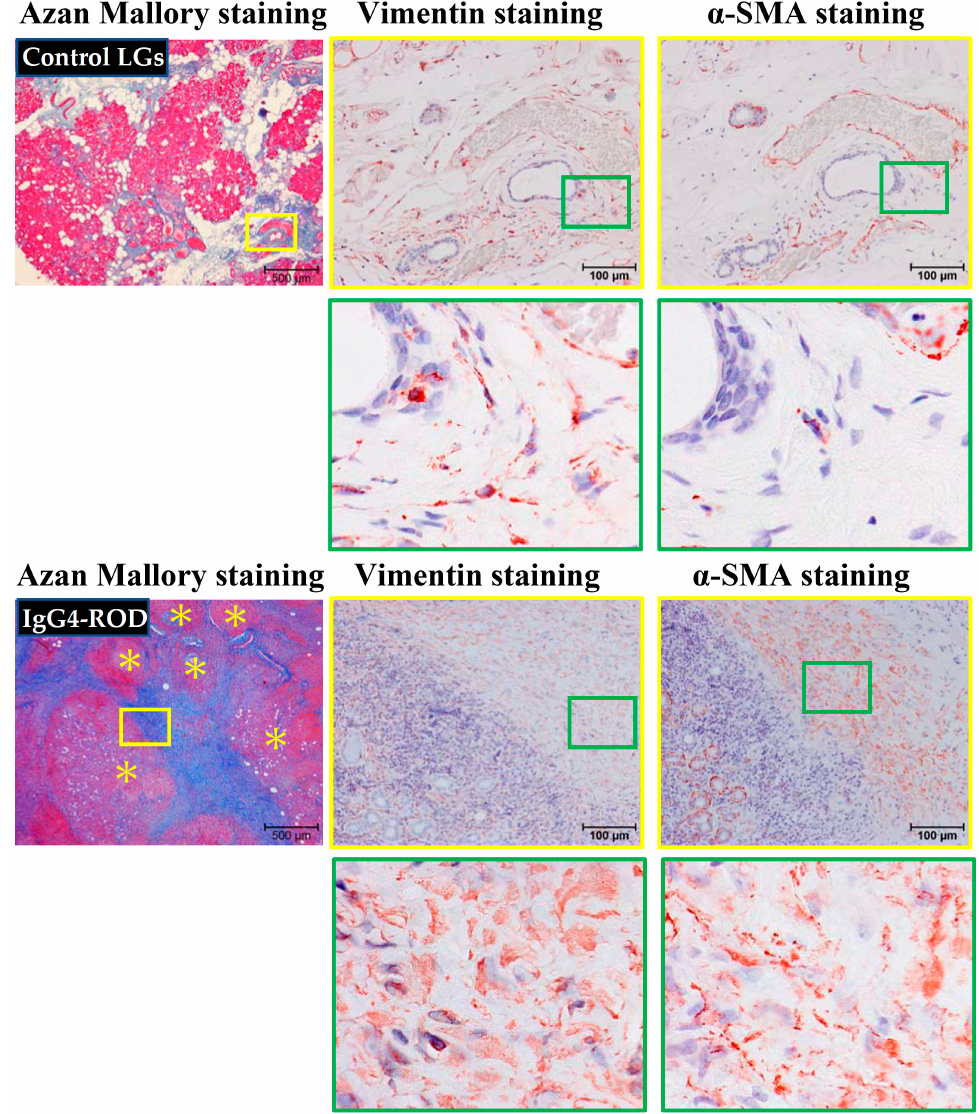
Figure 7. Representative images of vimentin and α -SMA immunostaining performed on serial sections of LGs obtained from patients with IgG4-ROD and from control patients diagnosed with severe canalicular obstruction, but with no IgG4-ROD. These loci were matched with the yellow frames of Azan Mallory-stained sections, shown in the left column. The images of green frames in the bottoms are indicating the enlargement of loci surrounded by green squares. Yellow asterisks indicate the area of lymphocytic hyperplasia.